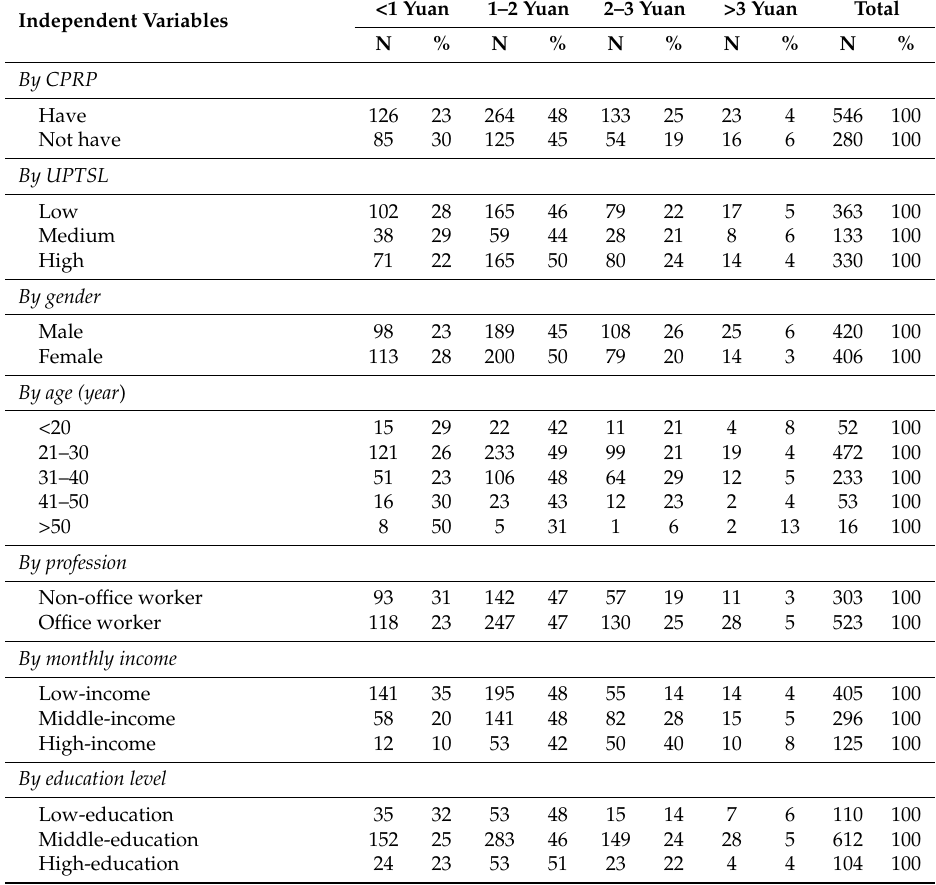
Table 3. Statistical information of participants’ highest acceptable price based on different categories of independent